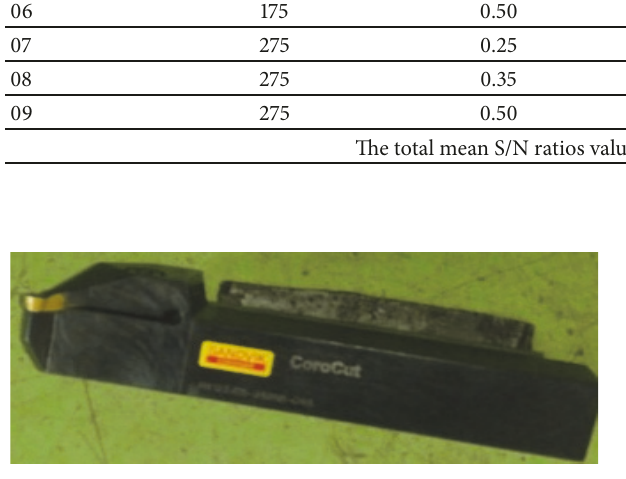
Figure 3: Tool of Sandvik Coromant carbide insert cutter with dimensions of 20 x 20 x 200 mm (w × h × l in